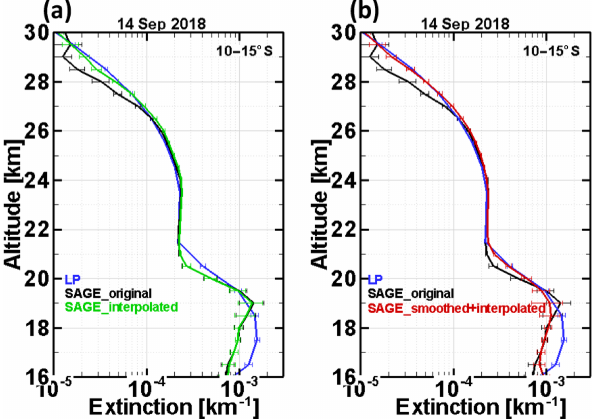
Figure 3. An example LP–SAGE comparison of average extinc- tion profiles in the 10–15 ◦ S latitude band for 1d, 14 Septem- ber 2018. (a) Comparison of extinction profiles among original SAGE (black), interpolated SAGE (green), and retrieved LP (blue). (b) Comparison of extinction profiles between the smoothed ver- sion of the recalculated SAGE profile (red) and the LP retrieval profile. Applying a combination of the smoothing and interpola- tion approaches to the original SAGE data improves the compari- son above 19km. The horizontal error bars on the mean extinction √ N profiles indicate the standard error of the mean, σ/